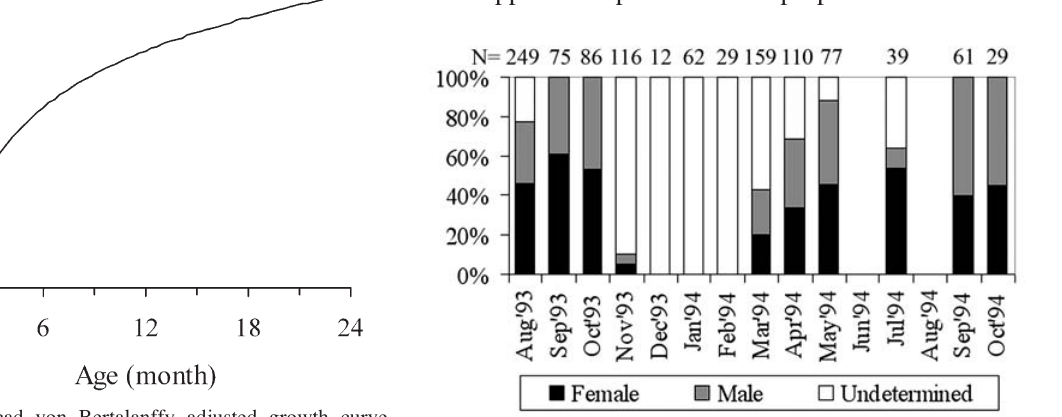
F IG . 4. – Bigeye scad von Bertalanffy adjusted growth curve, calculated with parameter estimations using ELEFAN software. F IG . 5. – Monthly distribution of